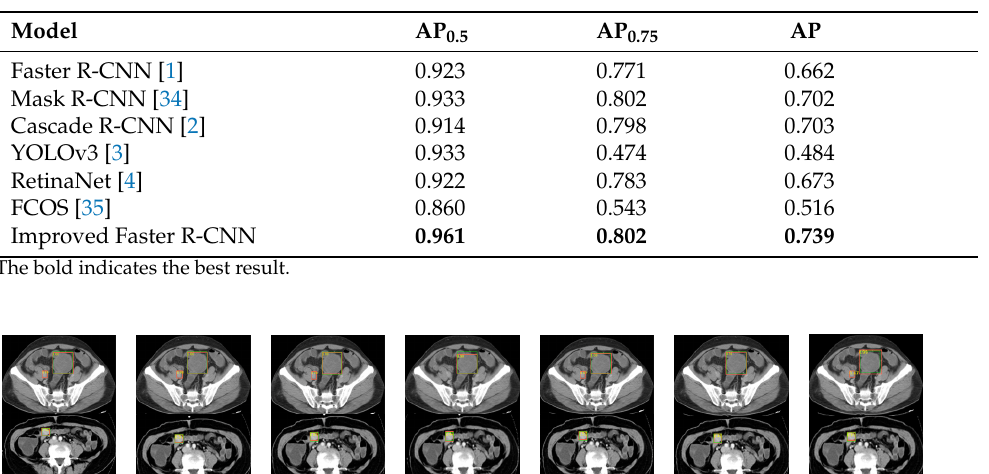
Table 7. Comparison with the state-of-the-art object detection algorithms.